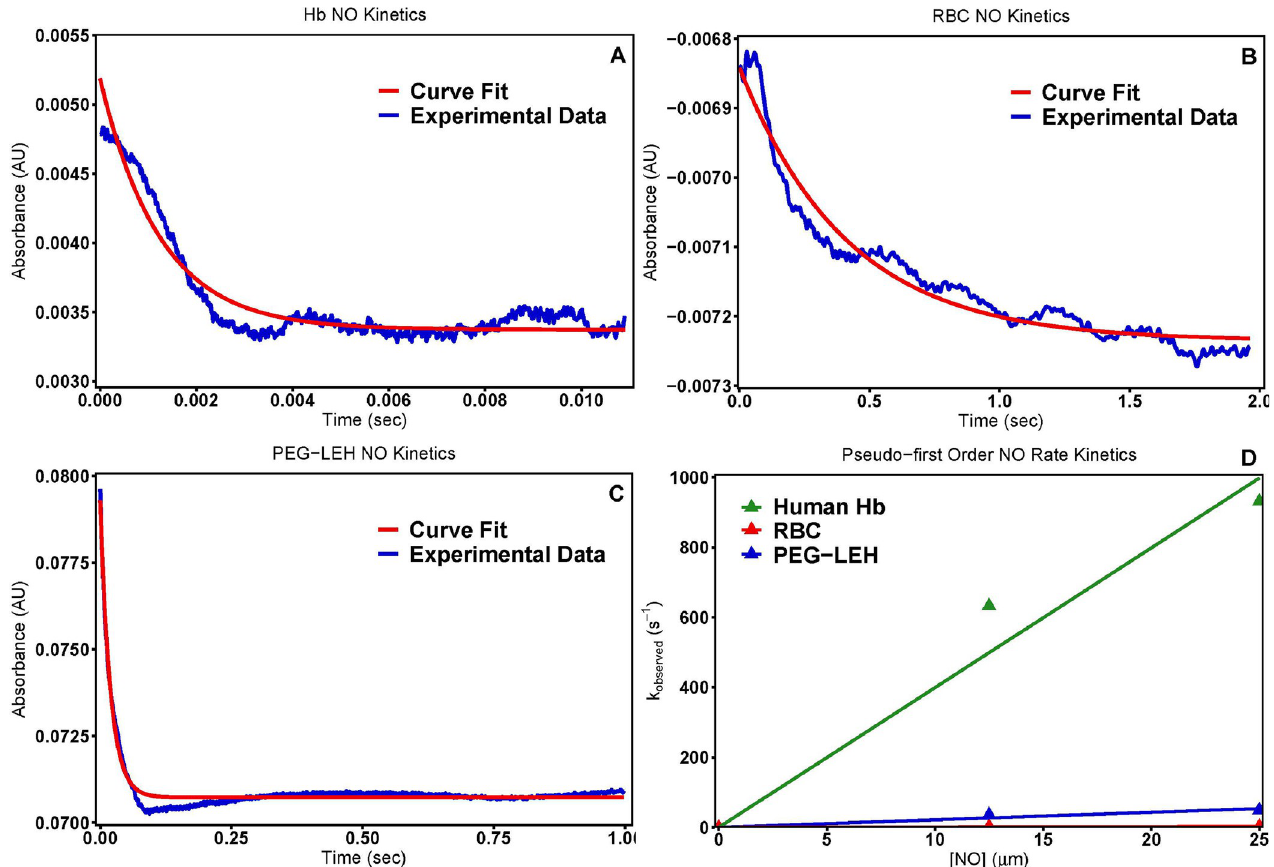
Fig 6. NO rate kinetics. Time courses for the NO (25 μ M) dioxygenation reaction with oxygenated (A) Hb, (B) RBCs, and (C) PEG-LEH nanoparticles. The experimental data shows an average of 10–15 kinetic traces. Reactions were monitored at 420 nm and 20˚C. (D) Comparison of pseudo first order NO dioxygenation rate constants for human Hb, RBCs and PEG-LEH nanoparticles as a function of [NO].